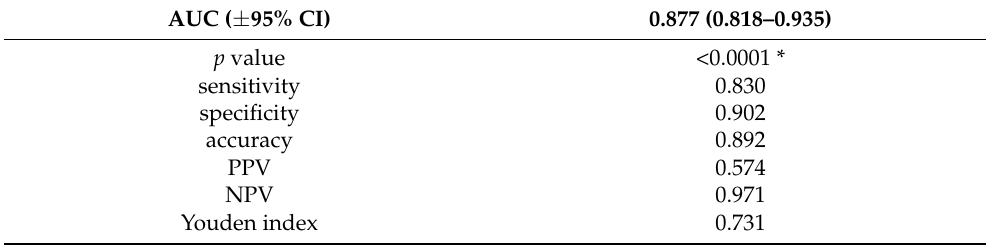
Table 3. Diagnostic potential of TSH level as a marker of the presence of thyroid cancer.